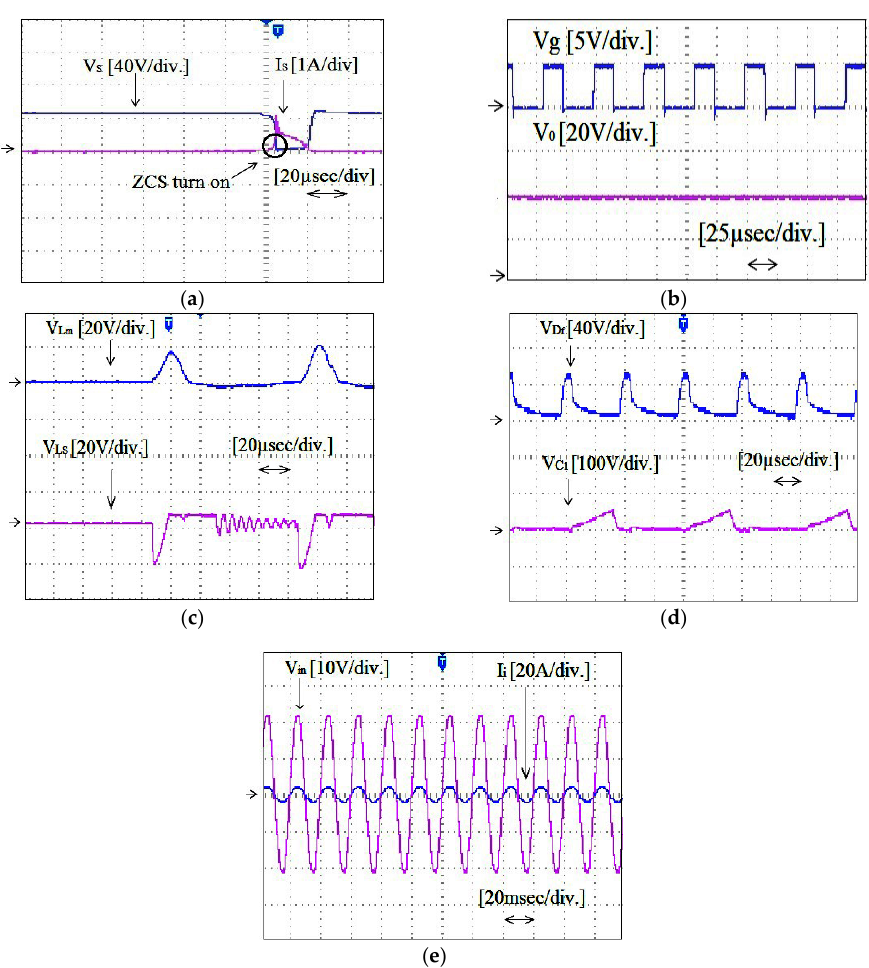
Figure 6. Measured waveforms for the proposed converter ( a ) V S and I S ( b ) V g and V 0 ( c ) voltage across L m and L S ( d ) voltage across D f and C 1 and ( e ) V in and I i .